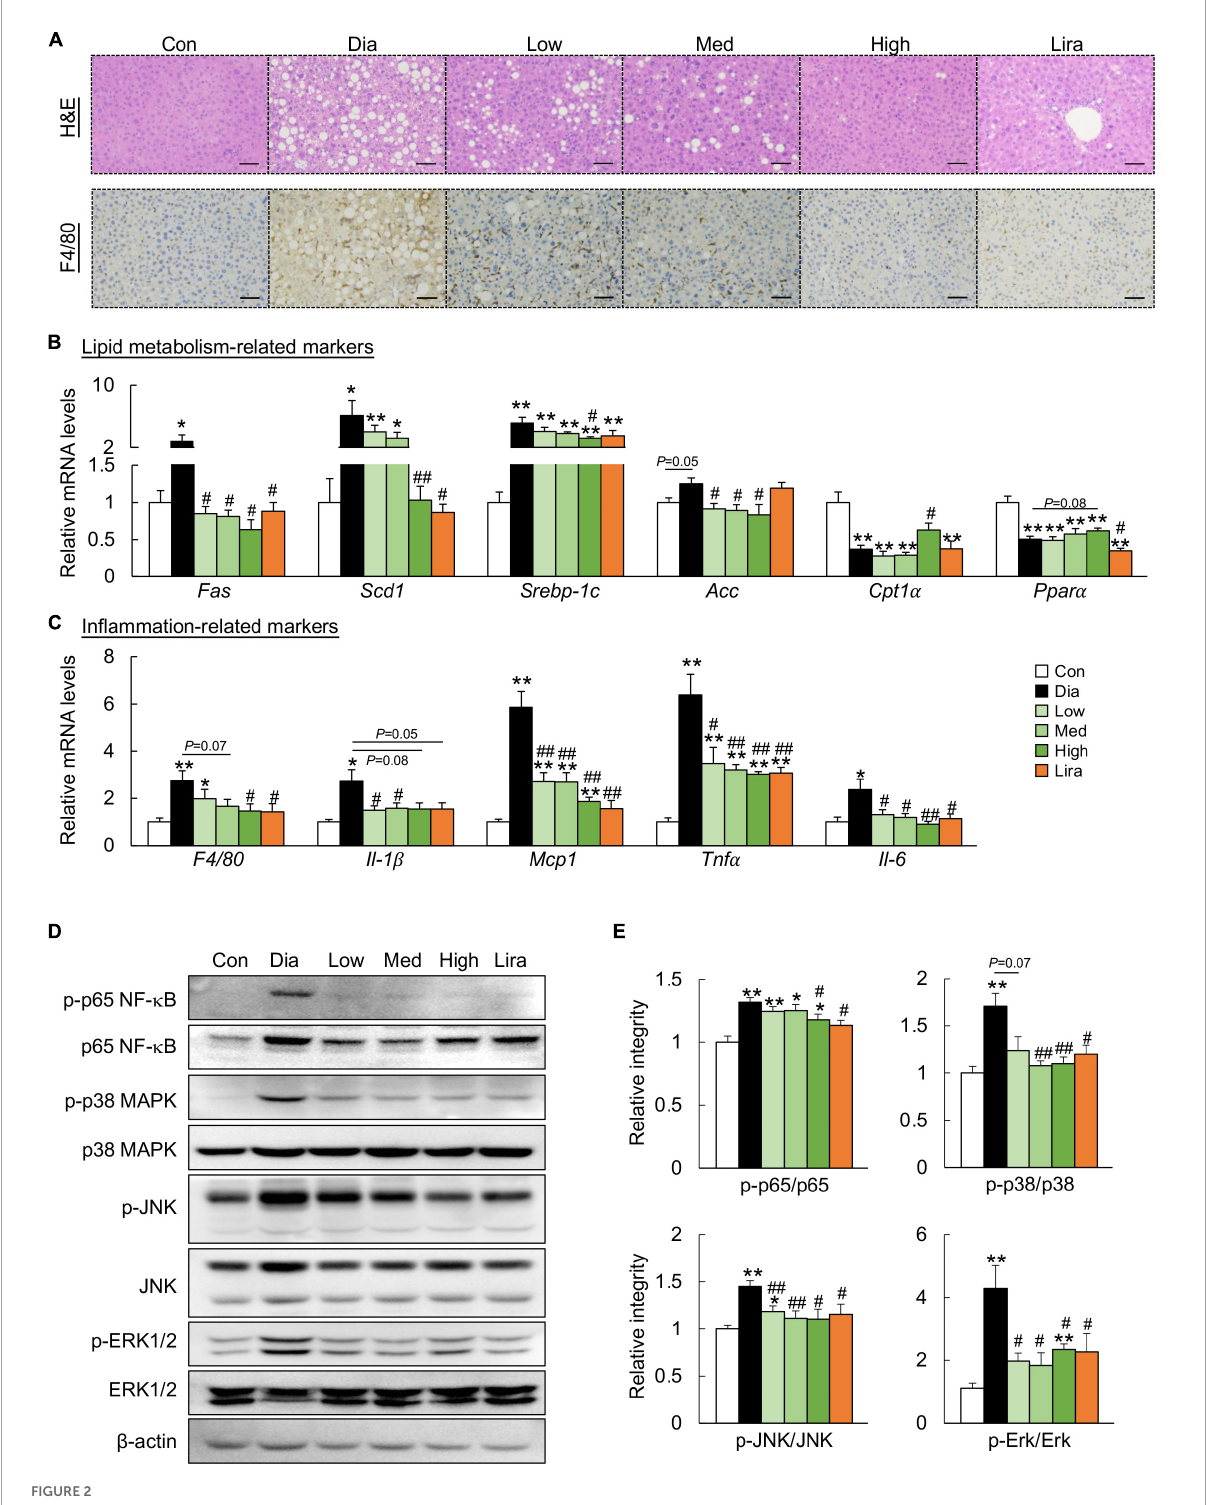
FIGURE2 CFP administration ameliorates metabolic disorders in the liver. (A) H&E-staining and immunohistochemistry staining for F4/80 in the liver, Scale bar: 100 µ m. (B) mRNA expression of the lipid metabolism-related markers in the liver. (C) mRNA expression of the inflammation-related markers in the liver. (D) Immunoblots of p-p65 NF- κ B, p65 NF- κ B, p-p38 MAPK, p38 MAPK, p-JNK, JNK, p-ERK1/2, and ERK1/2 in the liver. (E) Quantification data for p-p65 NF- κ B, p65 NF- κ B, p-p38 MAPK, p38 MAPK, p-JNK, JNK, p-ERK1/2, and ERK1/2 in the liver. Data are presented as the means ± SEM, * P < 0.05, ** P < 0.01 vs. control; # P < 0.05, ## P < 0.01 vs.